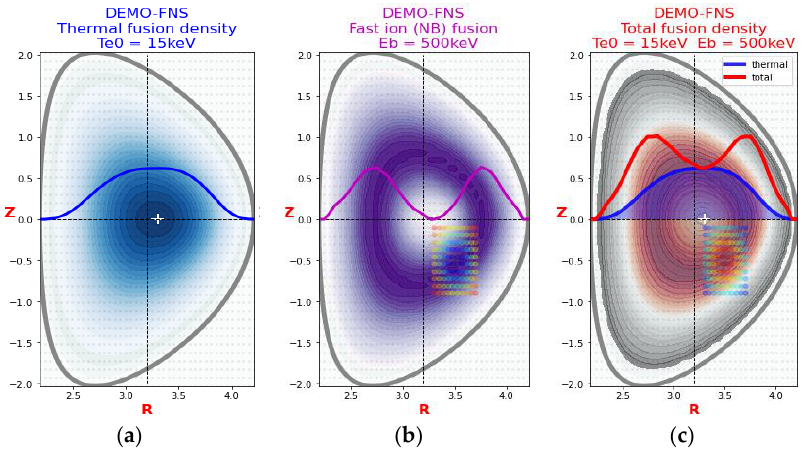
Figure 6. Fusion rate profiles in DEMO-FNS tokamak: ( a ) thermal fusion; ( b ) beam-plasma fusion; ( c ) total fusion rate (red) with thermal part (blue). NB tangent position R inj /Z inj = 3.5/ − 0.5 m; T e = 15 keV, n e = 1 × 10 20 m − 3 , E b = 500 keV.